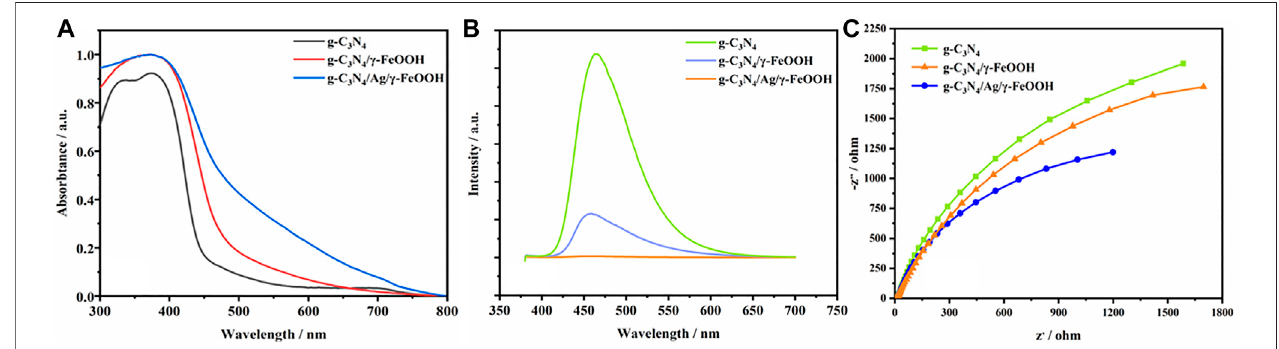
FIGURE 4 | (A) UV − vis absorption spectra of g-C 3 N 4 , g-C 3 N 4 / γ -FeOOH, g-C 3 N 4 /Ag/ γ -FeOOH, (B) Photoluminescence spectra of pure g-C 3 N 4 , g-C 3 N 4 / γ -FeOOH,